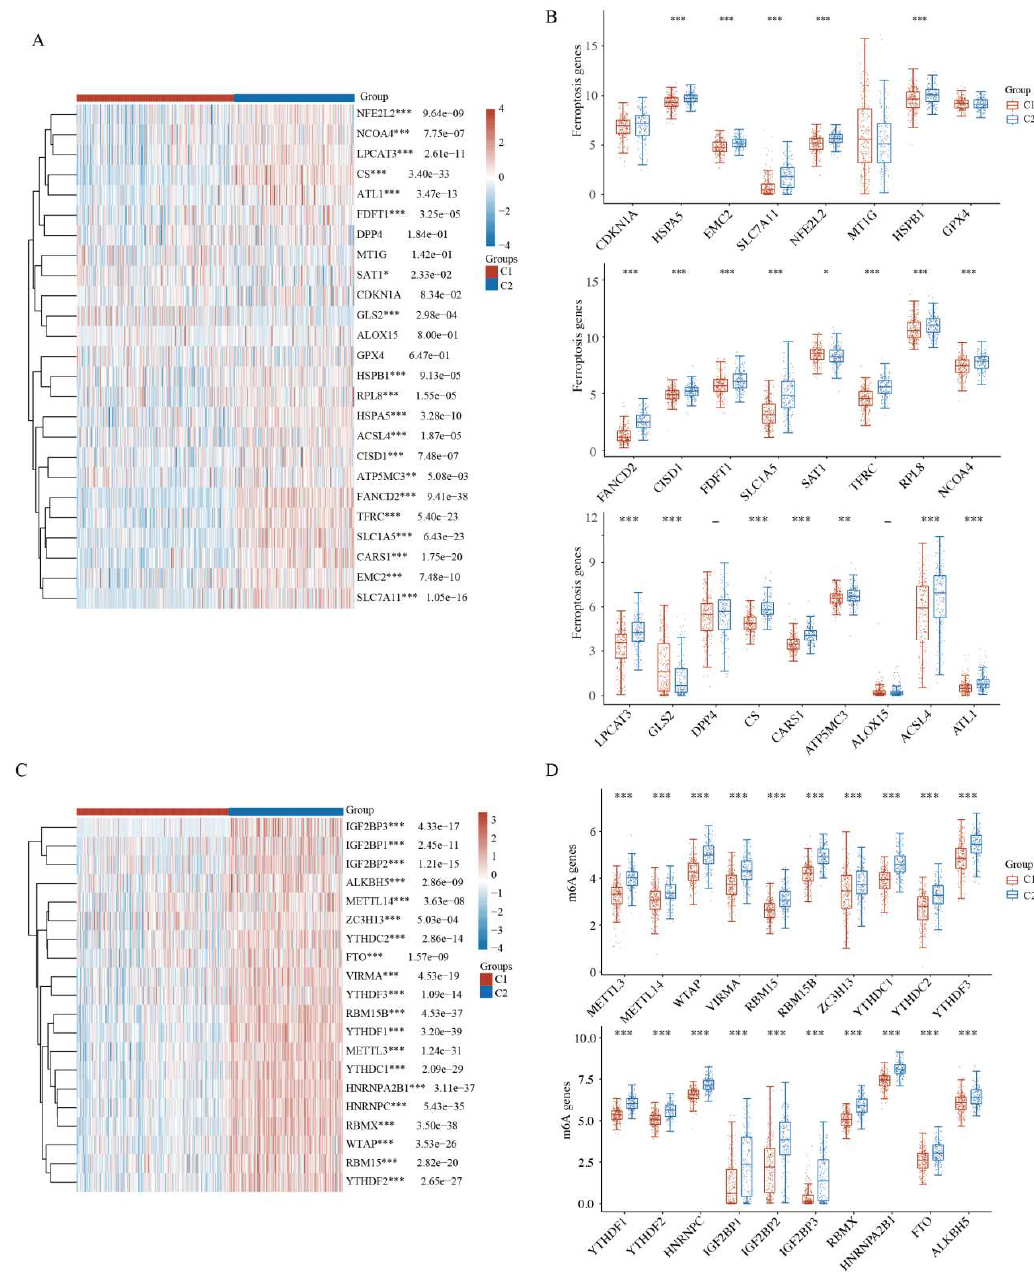
Figure 5. Ferroptosis and N6-methyladenosine analysis between HCC subgroups. ( A ) Heatmap of ferroptosis-related gene expression between two clusters. ( B ) Expression difference of ferroptosis- related genes between the two clusters. ( C ) Heatmap of m 6 A-related gene expression between two clusters. ( D ) Expression difference of m 6 A-related genes between the two clusters. * p < 0.05, ** p < 0.01, *** p <